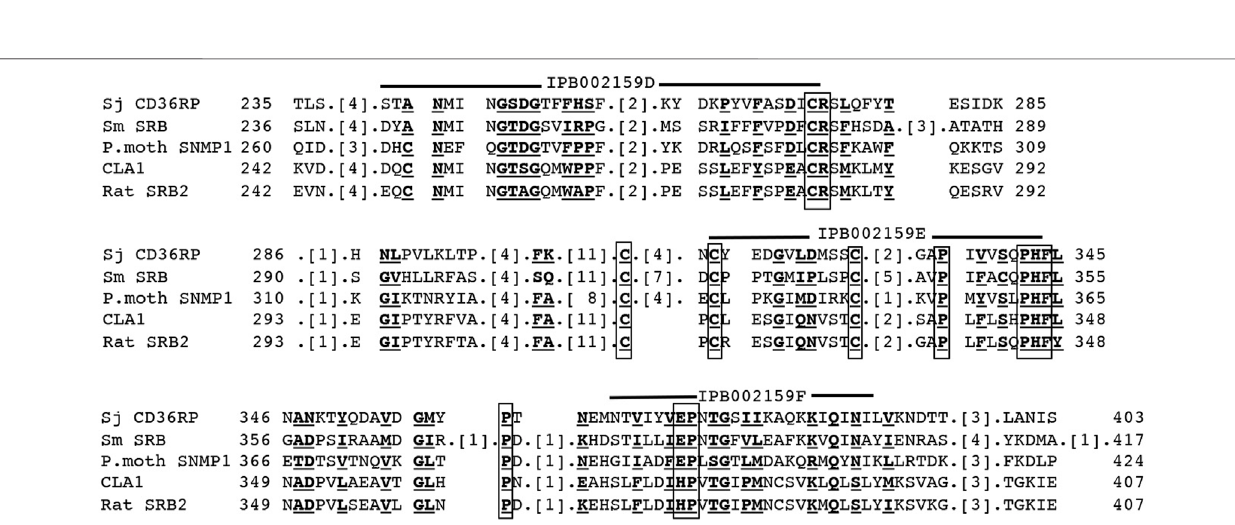
Frontiers in Cell and Developmental Biology |